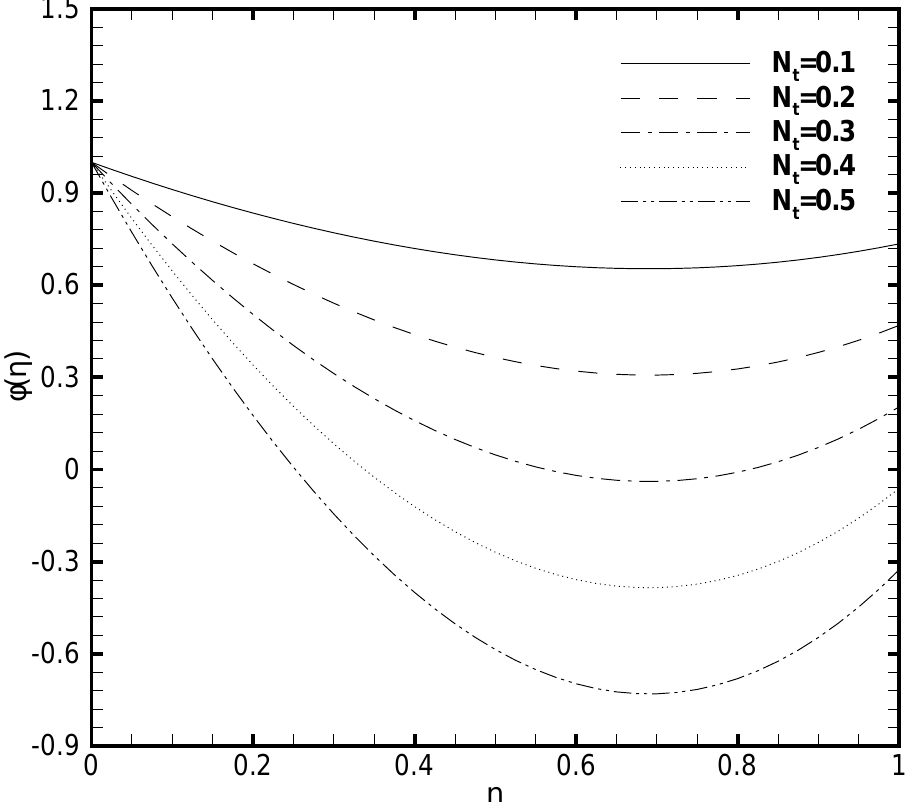
Figure 12. Nanoparticle volume fraction profile φ ( η ) for several values of thermophoresis parameter N t when ζ = P = κ = Ha = Br = δ θ 2 = F k = 1, N b = 0.2, β = 0.05 and δ θ 1 =